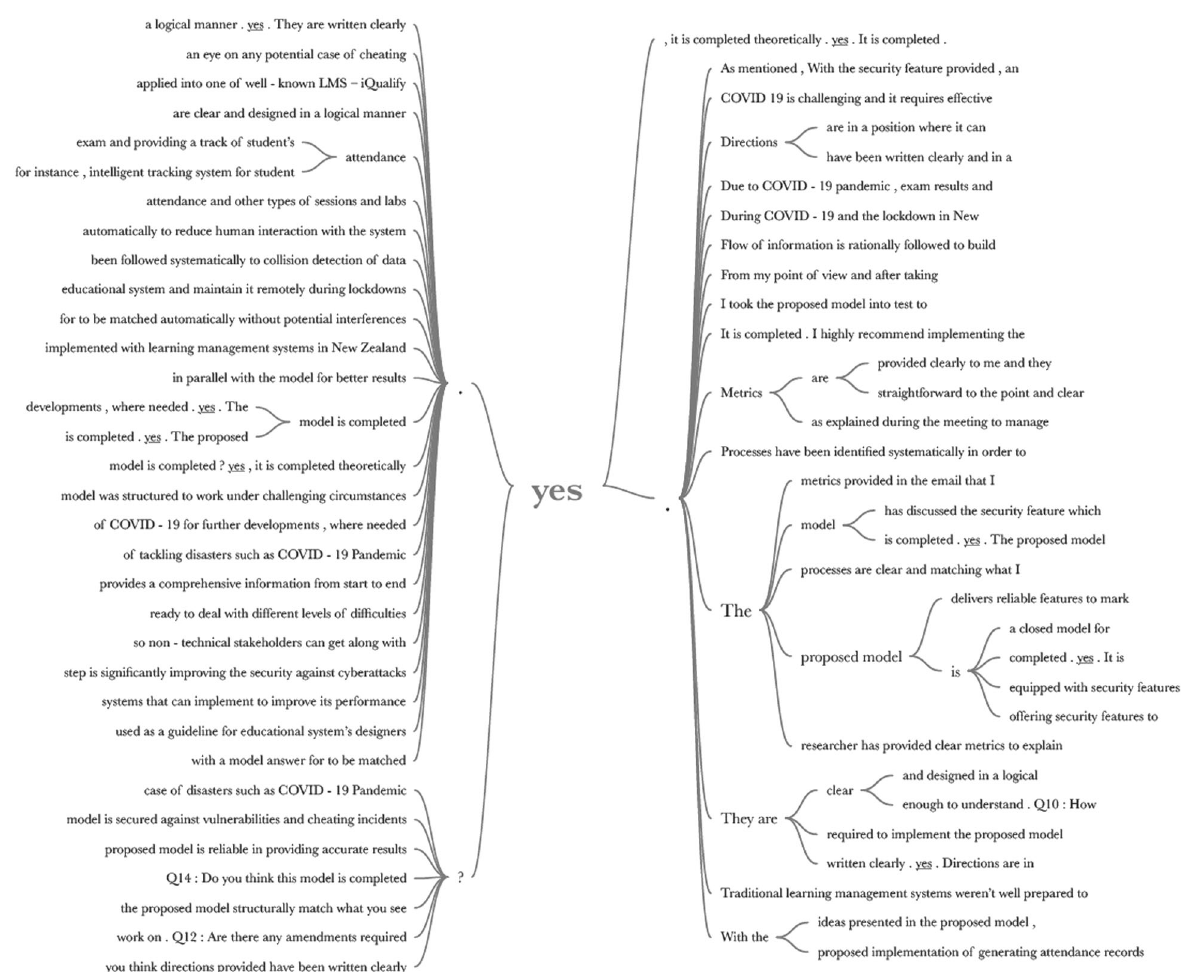
Fig. 8 Word tree “ yes ” .